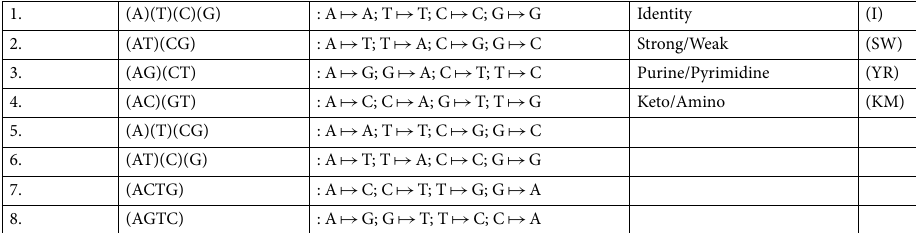
Table 3. Set of the 8 transformations of the nucleotides forming the dihedral group D 8 . The first 4 transformations of the nucleotides form also the Klein V symmetry group. These are indicated as transformations in the rightmost column.